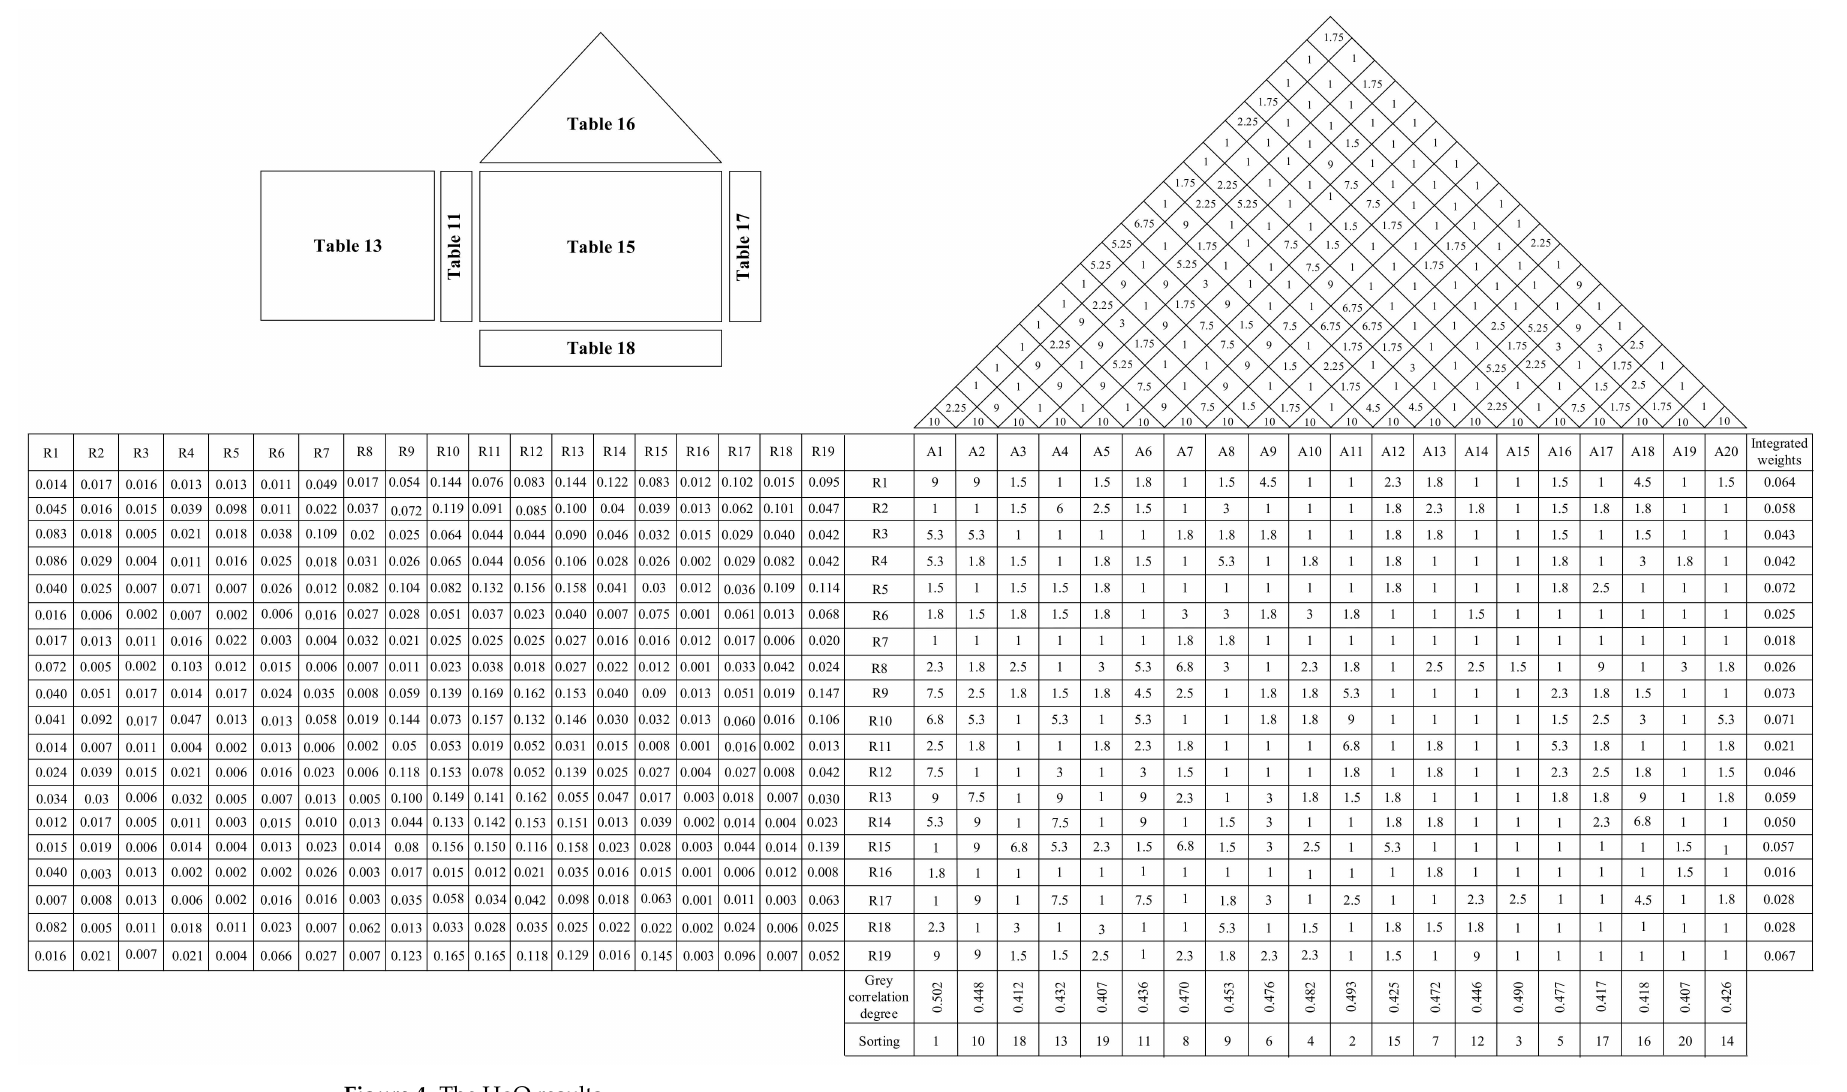
Figure 4. The HoQ